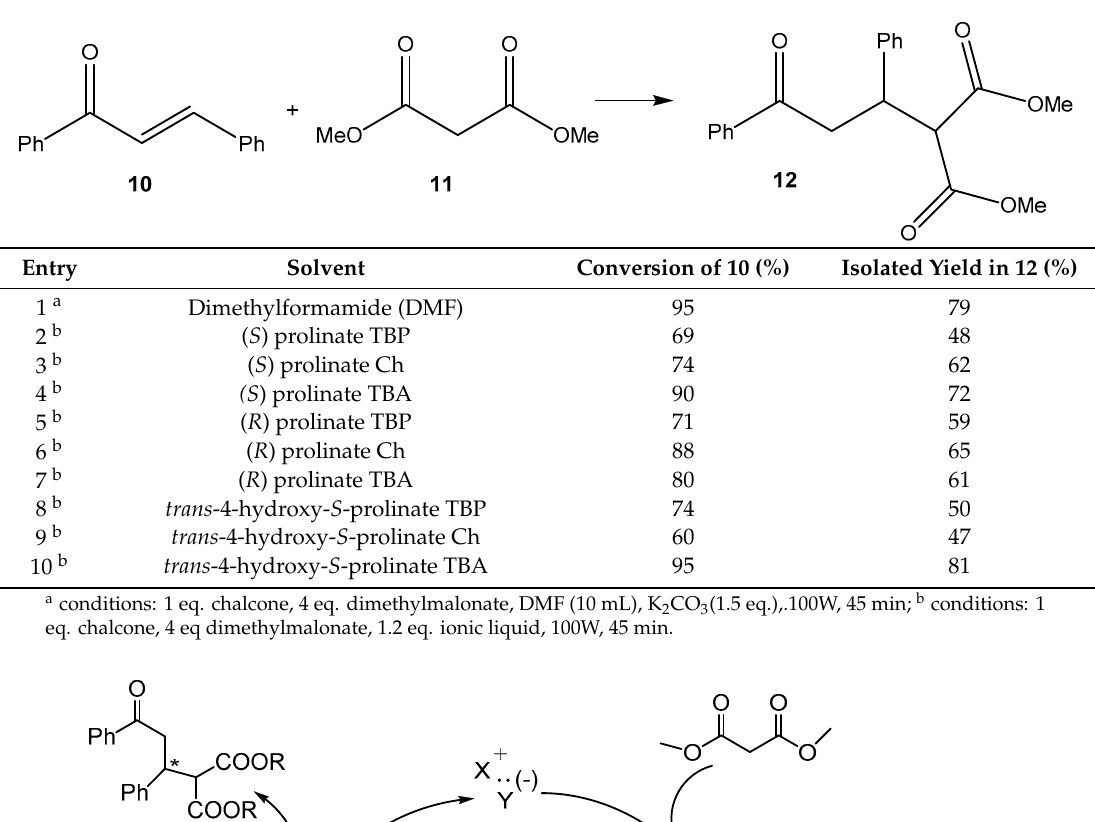
Table 4. Michael’s reaction under microwaves.